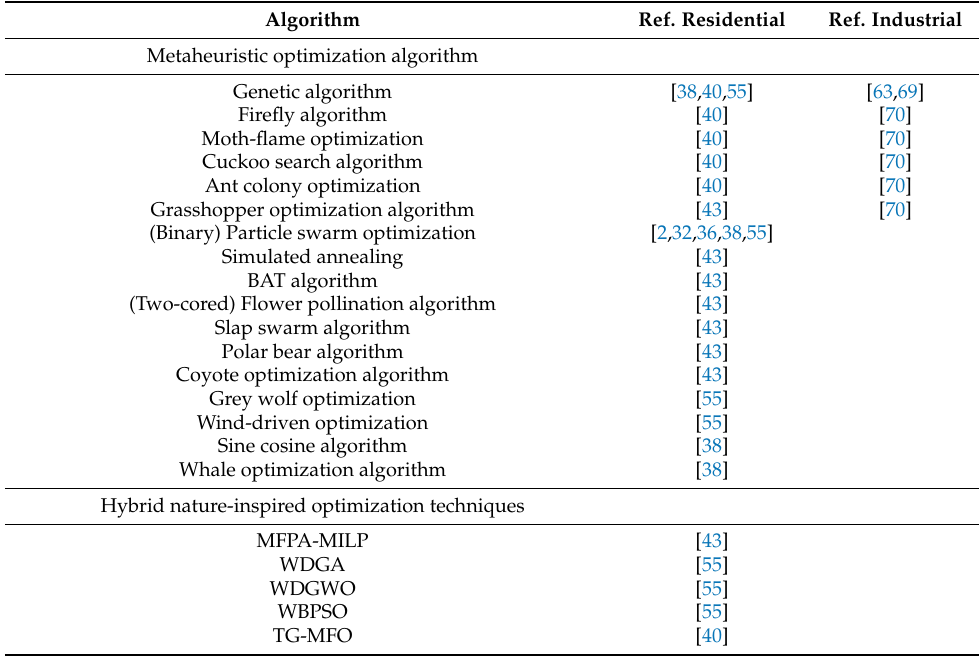
Table 7. Metaheuristic optimization techniques for energy management